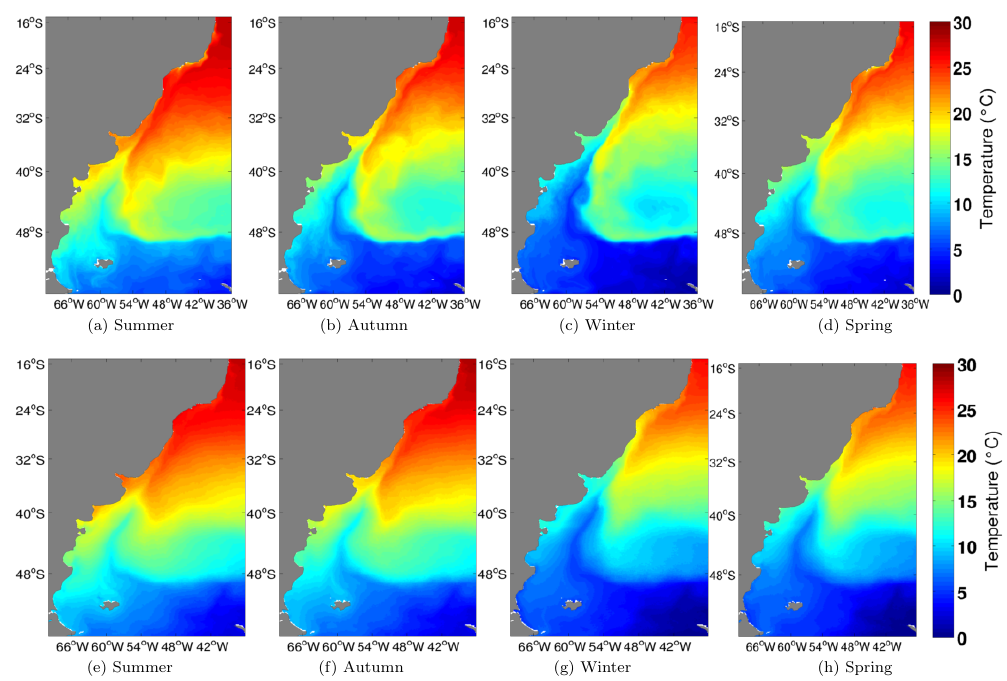
Figure A1. Seasonal climatology of modeled sea surface temperature ◦ C – 4 years average (upper row), and climatology from AVHRR sensor – from 1985 to 2002 (lower row).